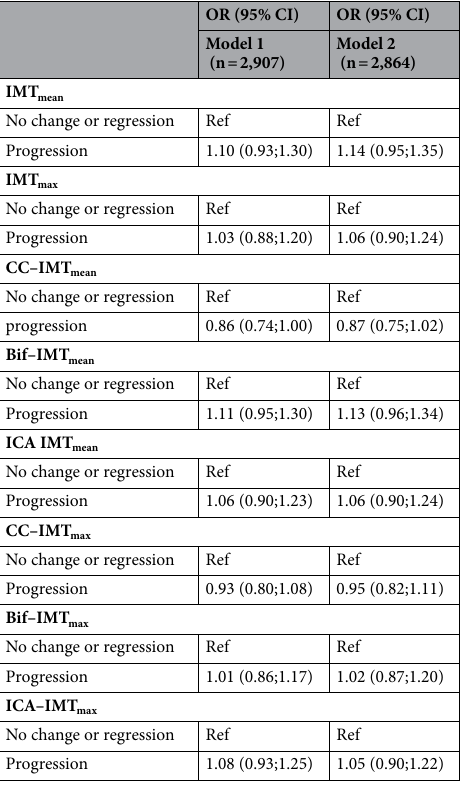
Table 3. Odd Ratios (OR) and 95% confidence interval (CI) for high consumption of food rich in saturated fats in relation to IMT progression (vs. no change or regression) in the participants of the IMPROVE study. Participants with missing information on progression (n = 307) and those who suffered a cardiovascular event during the follow-up (n = 193) are excluded. Model 1: Sex- and age-adjusted. Model 2: Model 1 plus level of education (categorical), physical activity (categorical), smoking, alcohol consumption (categorical) and population structure (MDS1-3